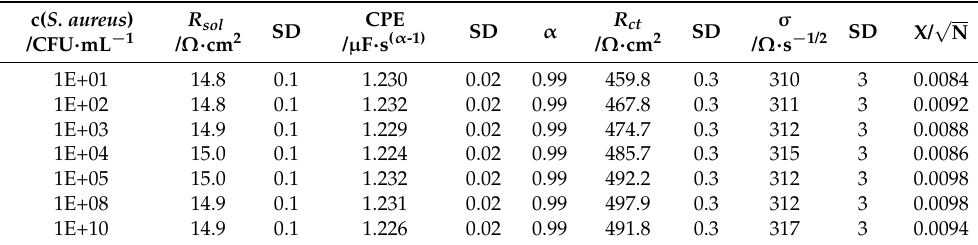
Figure 7. Electrochemical impedance spectroscopy (EIS) with S. aureus ( a ) Nyquist plot of a PAA-modified electrode before (cyan circles) and after incubation with 1 to 10 9 CFU · mL − 1 measured in FeBB—the fits to the equivalent circuit are shown as lines modified Randles circuit with R sol : solution resistance, CPE : constant phase element, R ct : charge-transfer resistance and W : Warburg impedance; ( b ) percentage change of the different fit parameters for all S. aureus concentrations, C eff : the effective capacitance was calculated from the CPE under the assumption of a parallel distribution of time constants on the electrode surface as described in [45], σ is the parameter for the Warburg element; ( c ) binding curve: Change of the extracted charge transfer resistance ∆ R ct of aptamer-modified electrodes upon incubation of 1 to 10 9 CFU · mL − 1 S. aureus measured in triplicate—dashed blue lines mark the 95% confidence interval, green cross marks a sample of unknown concentration; ( d ) unspecific signals: 10 6 CFU · mL − 1 of Staphylococcus epidermidis , Escherichia coli and Staphylococcus aureus on PAA-modified electrodes as well as 10 6 CFU · mL − 1 S. aureus on electrodes modified with random oligonucleotides measured in triplicate—the dashed line represents the LoD. Table 3. Results from the fitting of impedance data to the modified Randles circuit—SD = standard √ deviation, X/ N = error of fitting normalized to the number of data